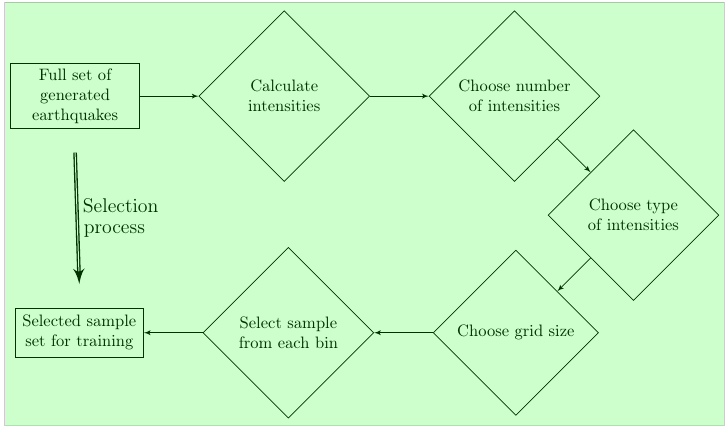
Figure 7. Flowchart of the proposed selection strategy for the training samples.